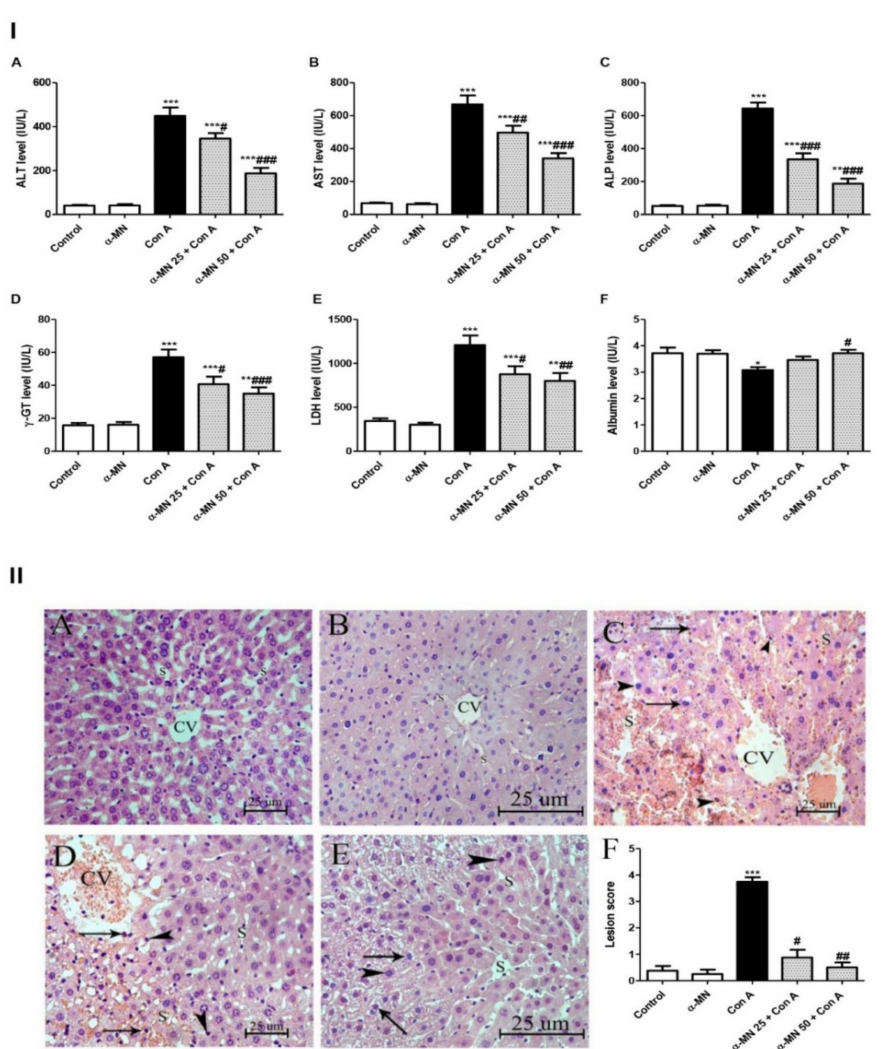
Figure 3. Alpha-mangostin ( α -MN) conferred protection against concanavalin-A (Con A)-induced hepatitis: improvement of biochemical and histopathological indices of the hepatic injury. ( I ) ( A ): Ala- nine aminotransferase (ALT); ( B ): Aspartate aminotransferase (AST); ( C ): Alkaline phosphatase (ALP); ( D ): Gamma-glutamyl transferase ( γ -GT); ( E ): Lactate dehydrogenase (LDH); ( F ): Albumin. ( II ) Hepatic sections stained with H&E ( × 400); ( A ): Control and ( B ): α -MN groups displayed normal hepatic architecture with the hepatocytes arranged in regular plates separated by the blood sinusoids (S) and radiating from around the CV (central vein); ( C ): Con A group showed marked hepatocytes trabeculation, hydropic degeneration, and apoptotic changes (arrow heads), diffuse intense sinusoidal congestion (S) and several inflammatory cell infiltrations (arrows); ( D ): α -MN 25 + Con A group showed alternating areas of multiacinar necrosis with the same pathological changes with areas of a normal hepatic structure; ( E ): α -MN 50 + Con A group showed a marked improvement with still hepatocytes having a vacculated cytoplasm and a less marked apoptotic nuclei and inflammatory cell infiltration; ( F ): Scores of the histopathological hepatic lesion. Data are the mean ± SE. ( n = 8); *** p < 0.001; ** p < 0.01; * p < 0.05 vs. control group; ### p < 0.001; ## p < 0.01, # p < 0.05 vs. Con A group (one-way